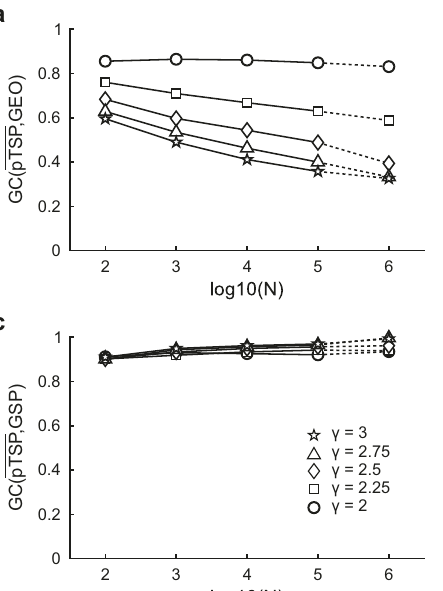
(over 10 network realizations) of the respective network measure for increasing network size. Error bars are not reported since negligible. In order to provide an estimation for networks of size N = 1,000,000, for each curve we used the spline algorithm to perform interpolation at N = [100, 1000, 10,000, 100,000] and extrapolation at N = 1,000,000, the resulting values are highlighted with dashed